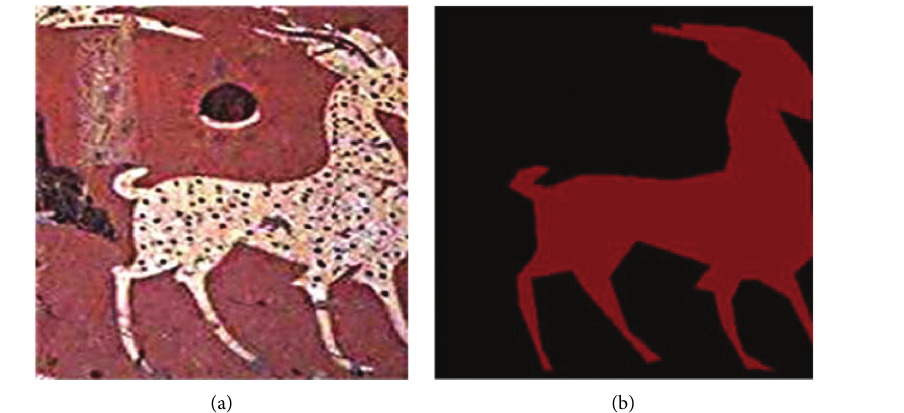
Figure 3: Sample plot of DeeplabV3+ dataset. (a) Scanned image of an ancient mural. (b) Label image of an ancient